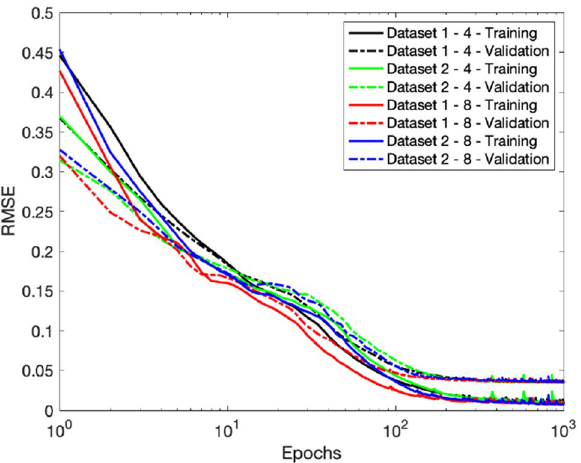
Figure 9. Average training and validation RMSE of ten runs, for the two datasets with a GRU-based recurrent layer with two different hidden sizes.